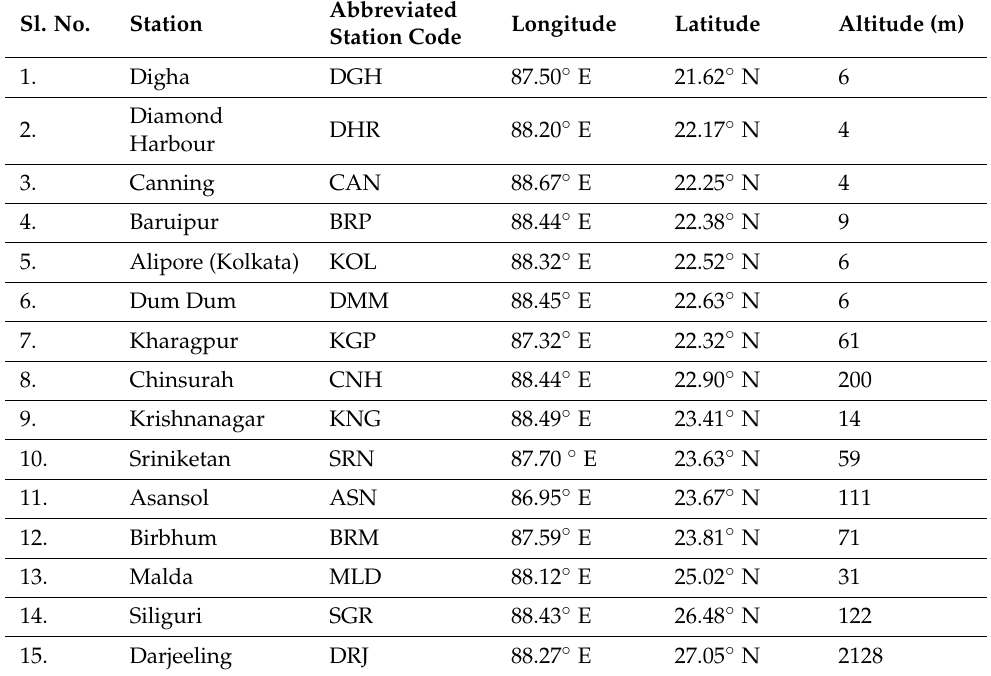
Table 1. List of the 15 selected stations with position coordinates along with their altitudes in WB for this